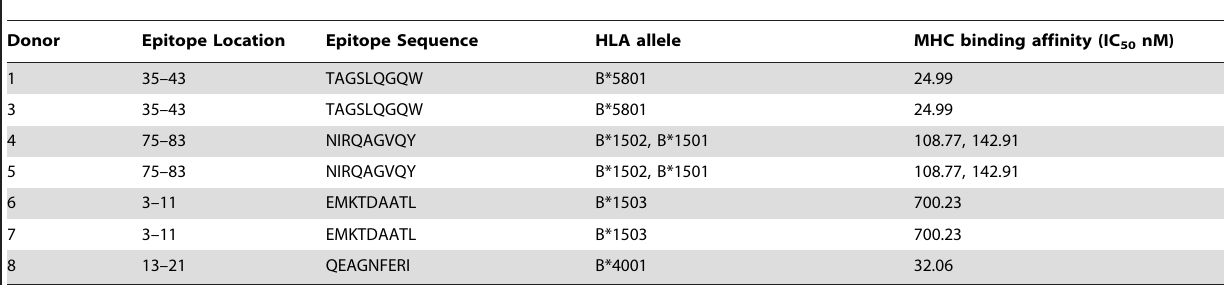
Table 2. Summary of CD8 + T cell epitopes and their MHC binding